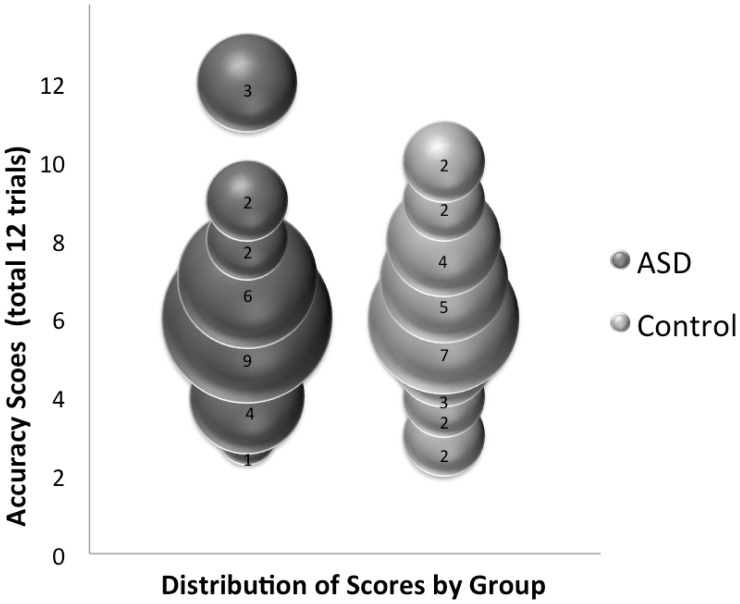
Distribution of absolute pitch scores by group.The size of the bubbles (and the number in each bubble) indicate the number of subjects who obtained each score (number correct out of 12 trials). The column of bubbles on the left represents the ASD data and the column on the right the control data. Three participants with ASD but no controls showed perfect performance, indicative of absolute pitch processing.